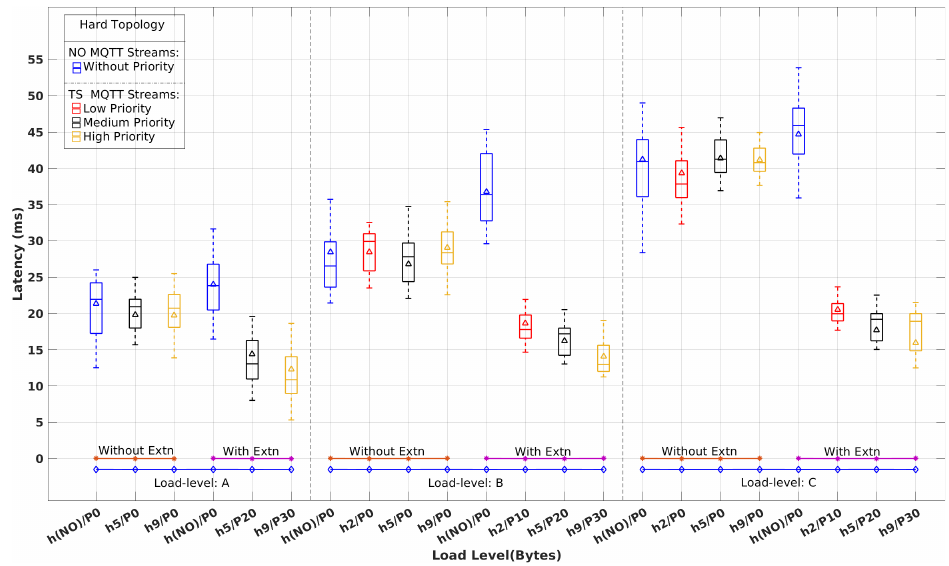
Figure 10. Latency of time-sensitive vs. normal MQTT flows with and without real-time extensions for the Hard topology and load levels A, B, and